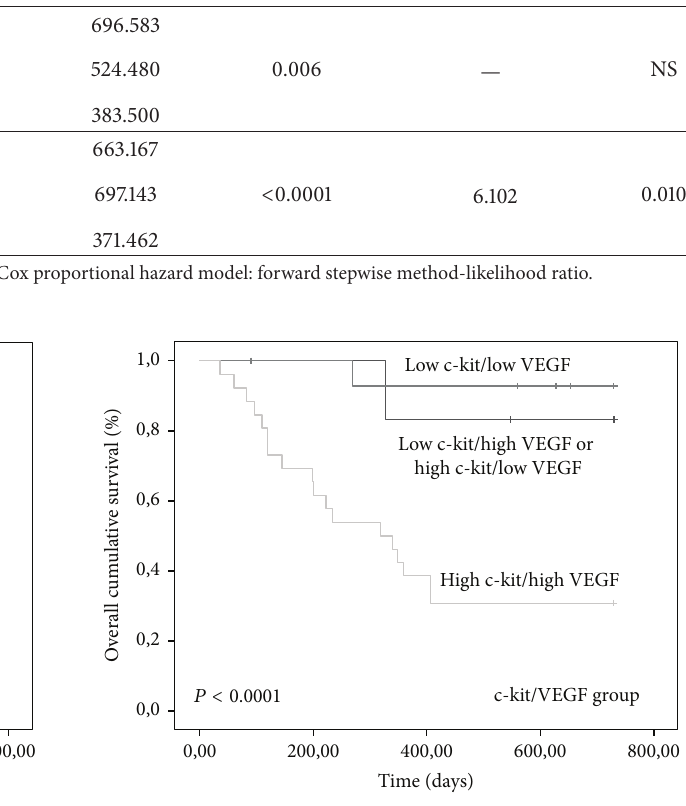
Figure 9: Kaplan-Meier overall survival curves comparing c- kit/VEGF group categories in 80 dogs with malignant mammary